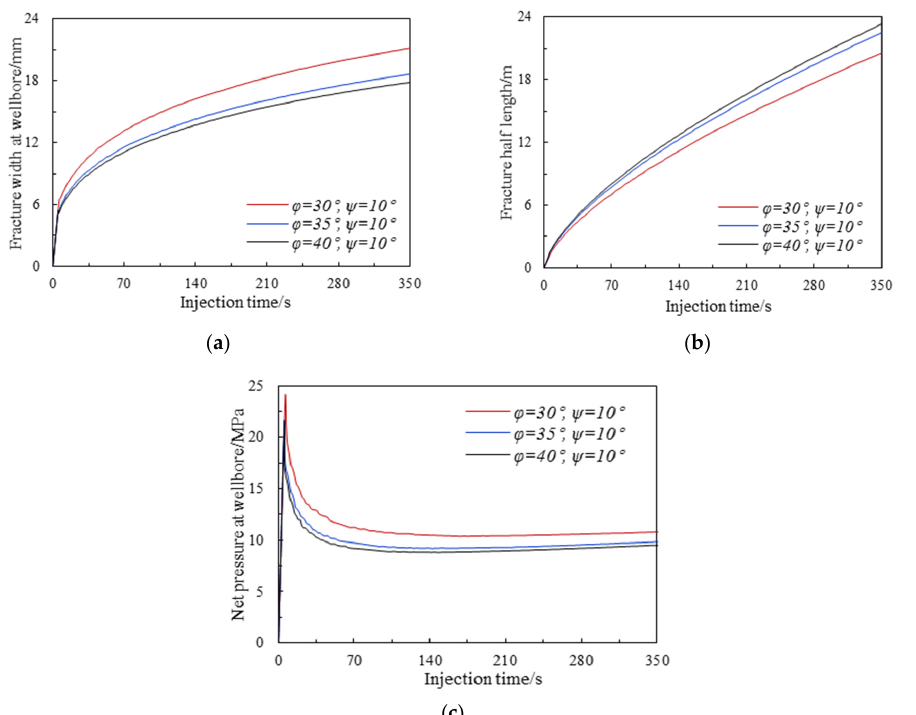
Figure 12. Numerical results with different internal friction angles. ( a ) Fracture width at wellbore; ( b ) fracture half-length; and ( c ) net pressure at wellbore.